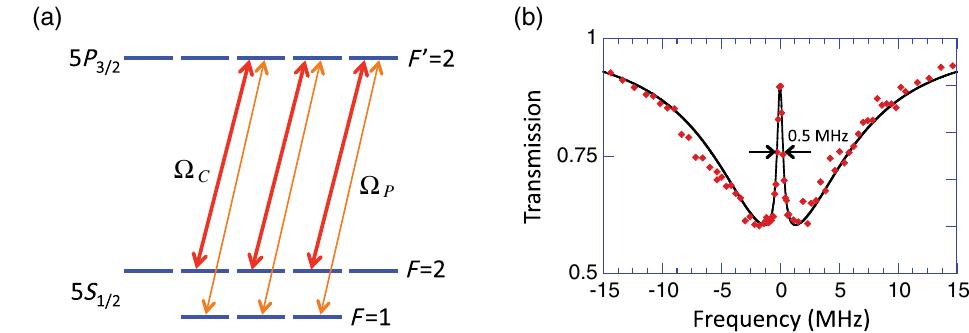
FIG. 3. (a) Energy-level schematic. We set up an EIT (cid:1) scheme in 87 Rb using F ¼ 1 ! F 0 ¼ 2 and F ¼ 2 ! F 0 ¼ 2 transitions in the D 2 line, and we address these transitions with the probe and coupling laser beams, respectively. We start the experiment by pumping atoms to the F ¼ 1 level, and the experiment works in three parallel m F channels. (b) The transmission of a weak focused probe laser through the atoms in the dipole trap as a function of frequency. We observe good EIT, with a transparency width of 0.5 MHz.